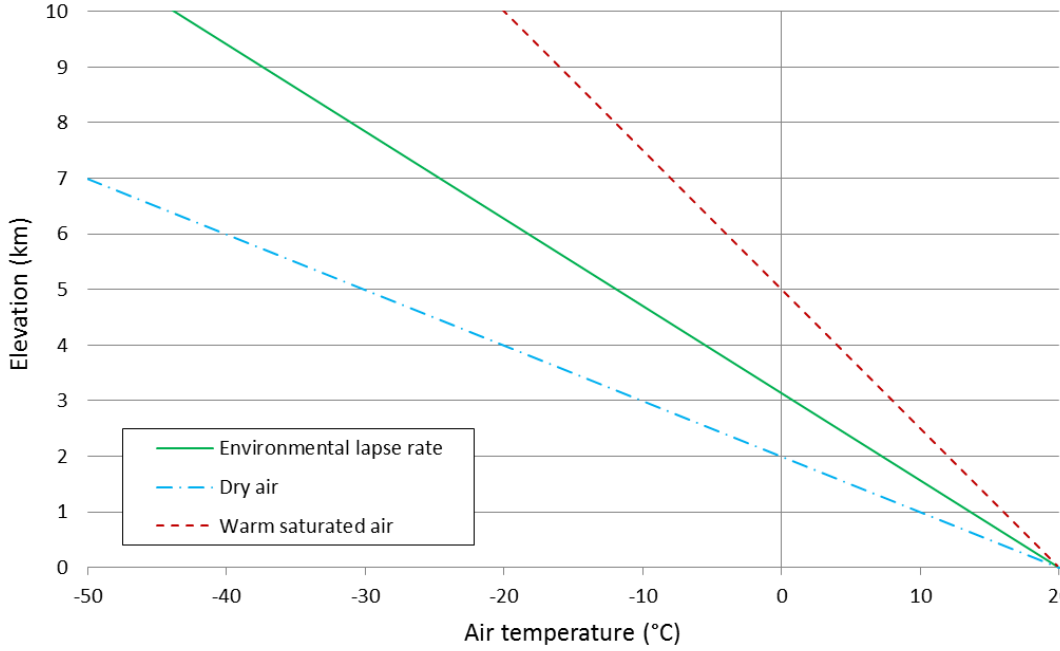
Figure 8. Dry, saturated and environmental lapse rates.